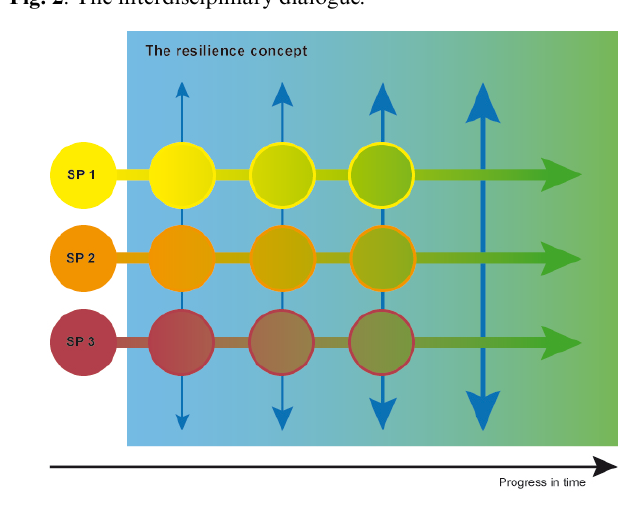
Fig. 2 . The interdisciplinary